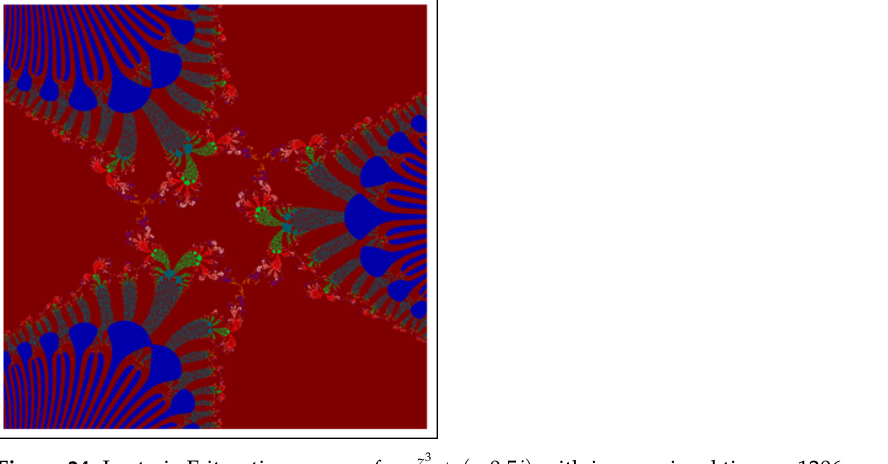
Figure 24. J-set via F-iterative process for e z 3 + ( − 0.5 i ) with image visual time = 1206 s.